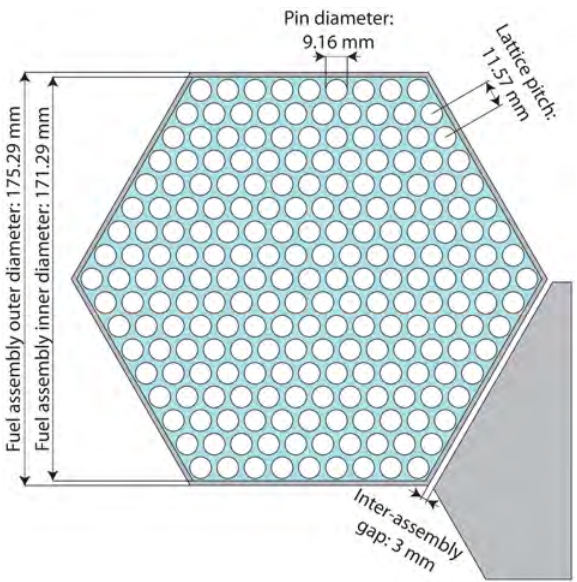
Figure 4. Cross sectional view of the GFR 2400 fuel assembly [15].